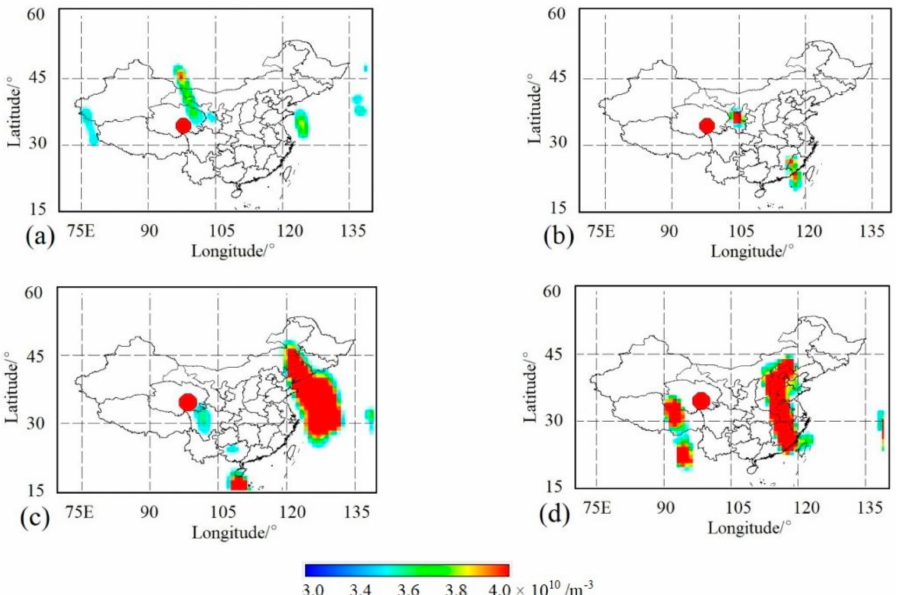
Figure 4. Variations in O + density during the periods of ( a ) April 28–May 4, ( b ) 5–11 May,